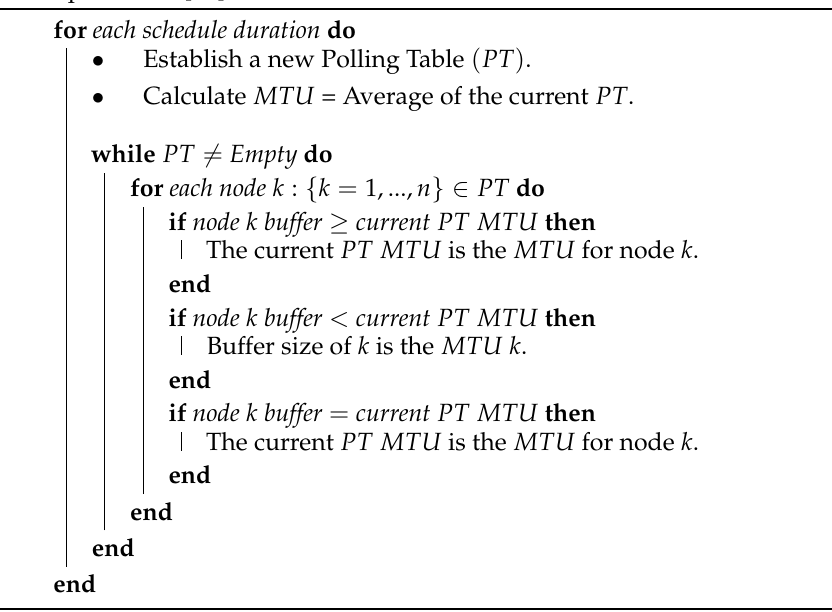
Algorithm 1: Dynamic future knowledge maximum transmission unit (DFK-MTU) algorithm adopted from